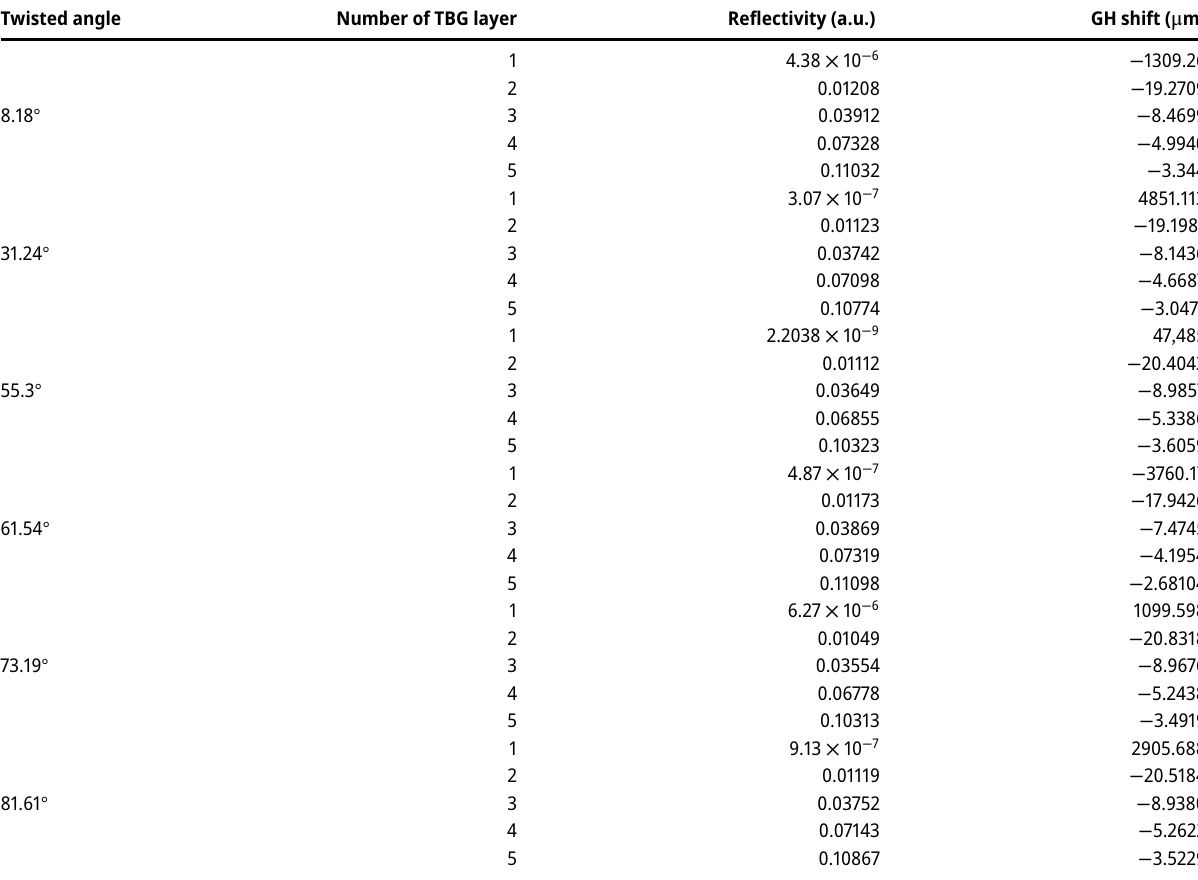
Table 2: Reflectivity and GH shift based on various twisted angles and number of TBG superlattice. Twisted